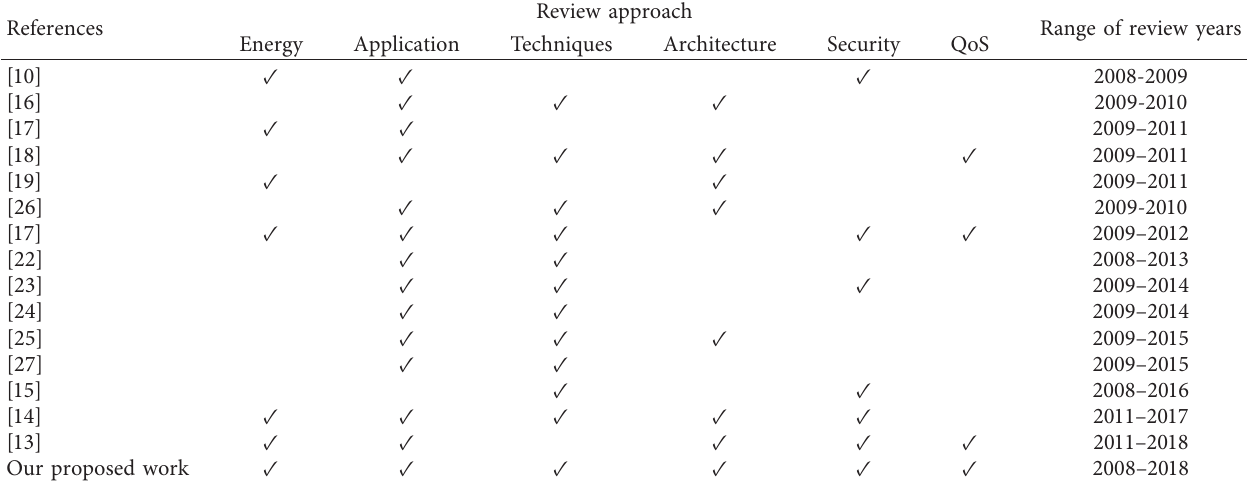
Table 1: Comparison of related